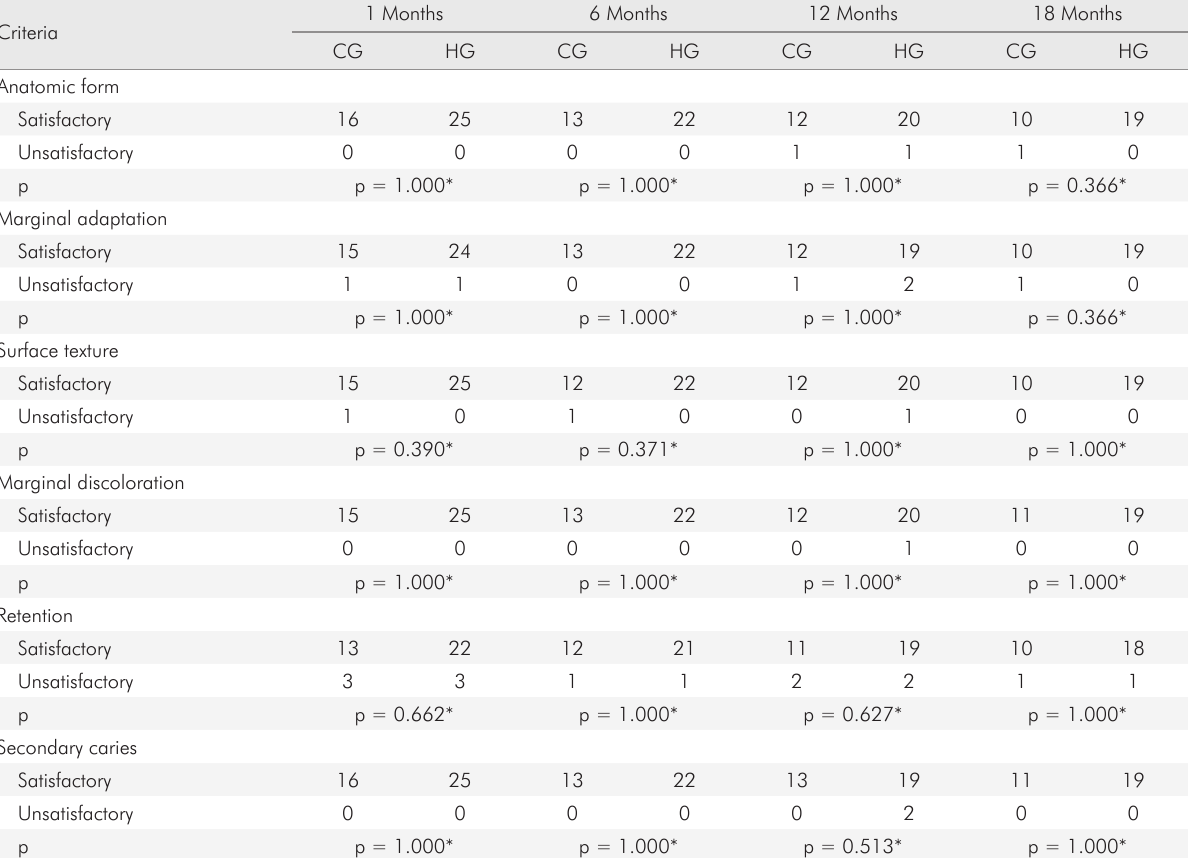
Table 4. Criteria for satisfactory and unsatisfactory sealants for CG (control group) and HG (affected group) at 1, 6, 12 and 18 months of follow-up.